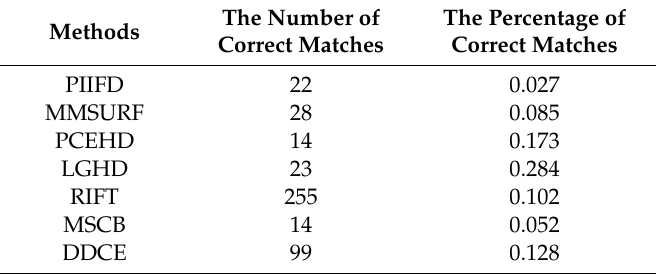
Table 5. The number and percentage of correct matches of multi-modality matching